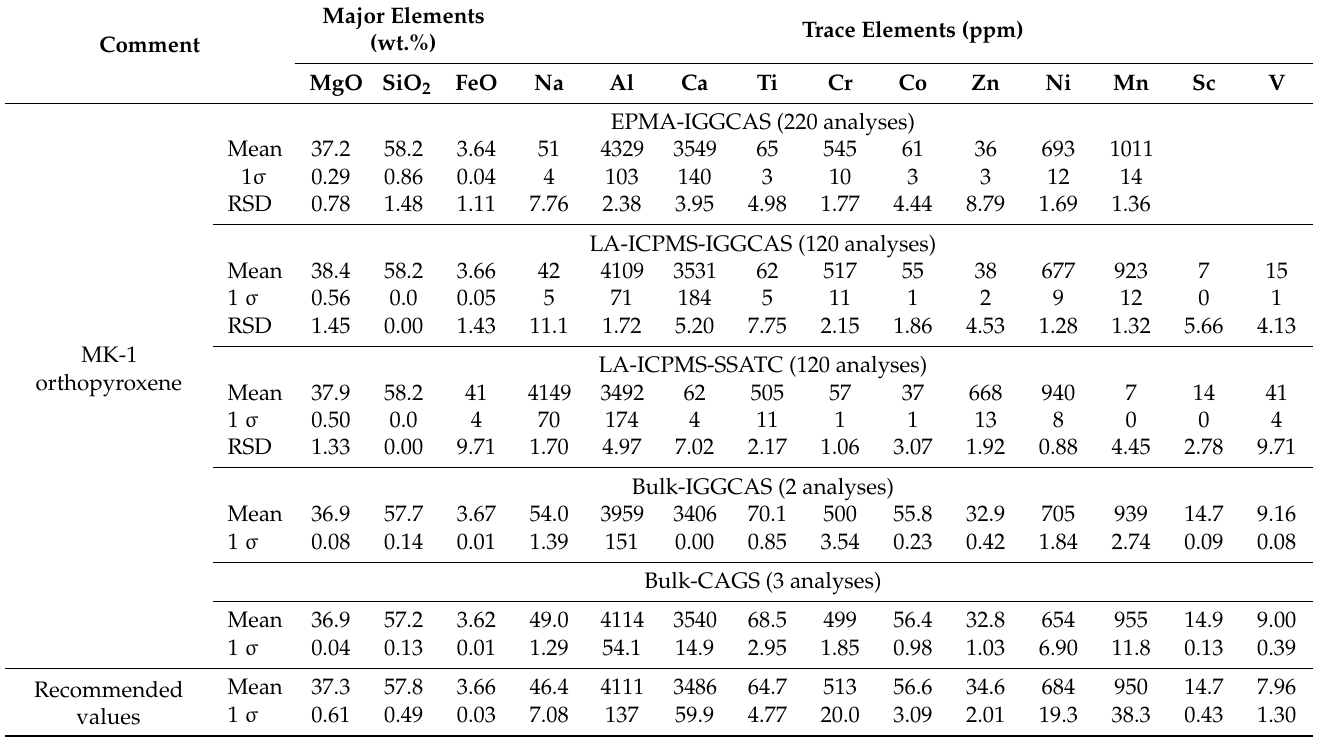
Table 2. Summary of all MK-1 orthopyroxene